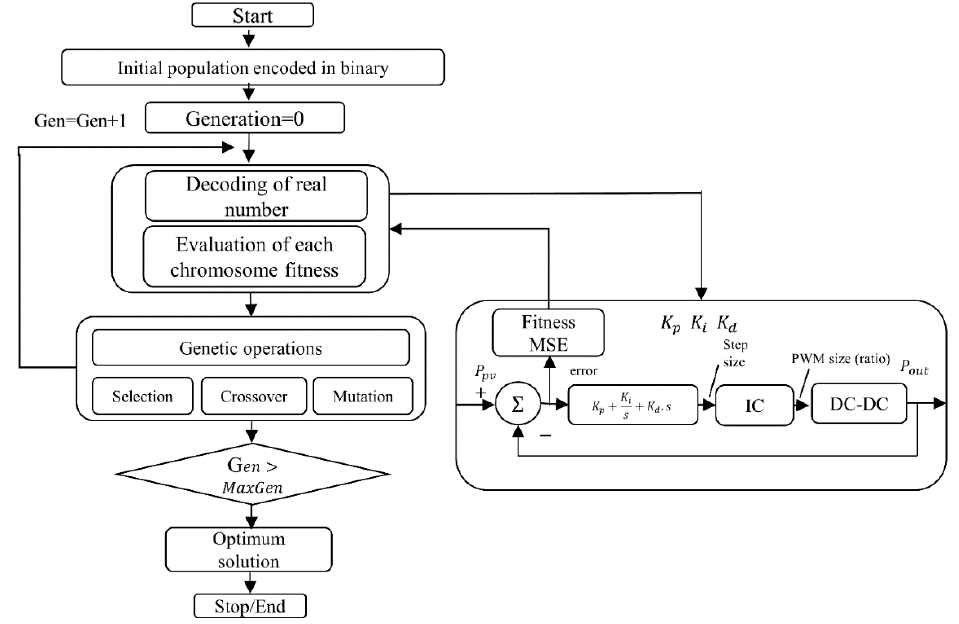
Figure 9. Detailed block diagram of the proposed system and tuning scheme.